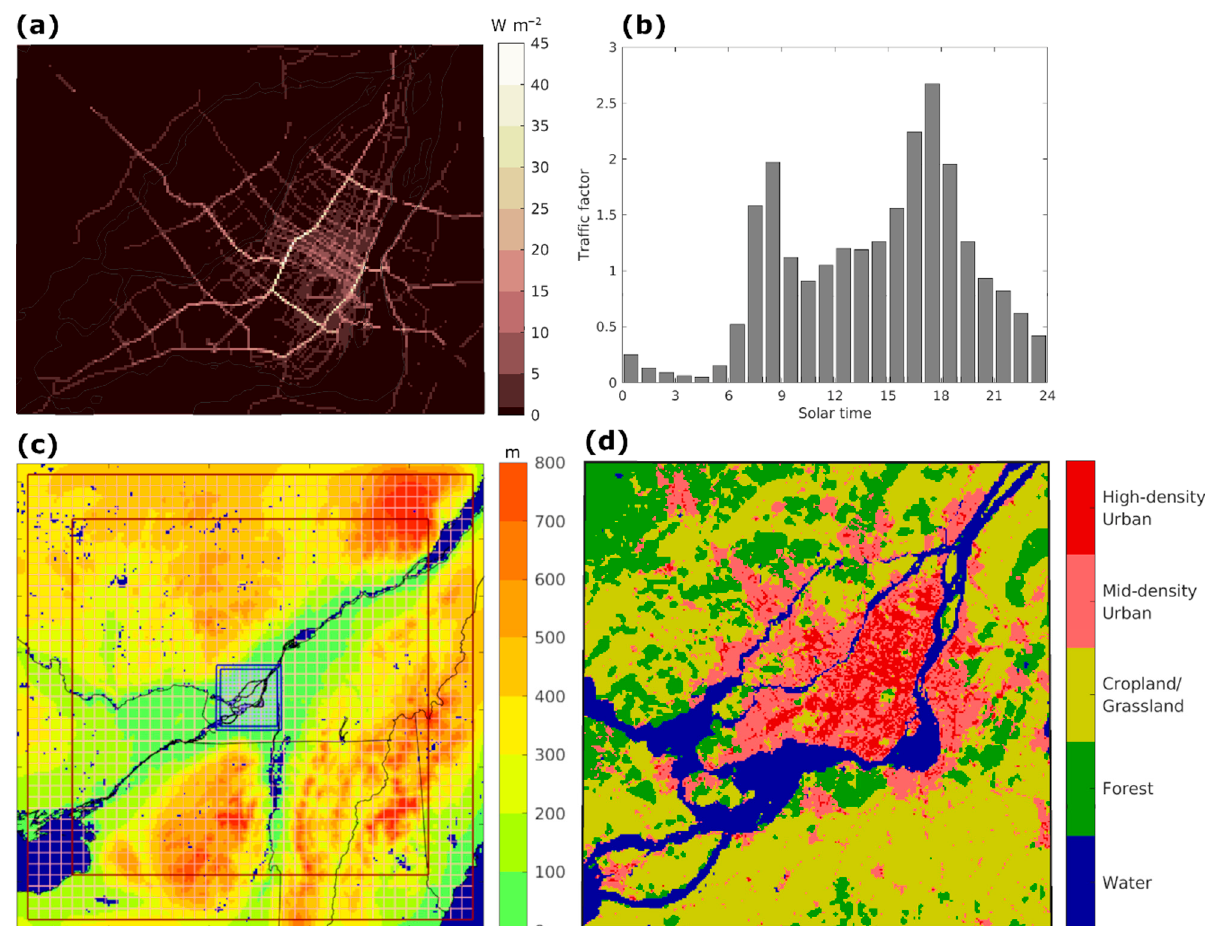
Figure 1. ( a ) Average anthropogenic sensible heat flux from traffic over Montreal. ( b ) Multiplicative factor for heat flux from traffic for each hour of the day. ( c ) Domains for GEM 2.5 km simulations (red; every 5th grid cell shown) and 250 m simulations (blue; every 20th grid cell shown). The outer thick lines represent the full domain, while the inner thick lines represent the free domain. Shading shows surface elevation and water bodies are shown in dark blue. ( d ) Predominant land cover in the 250 m domain. High-density urban is defined as urban fraction exceeding two thirds coverage, while mid-density urban is defined as the urban fraction with between one third and two thirds coverage.